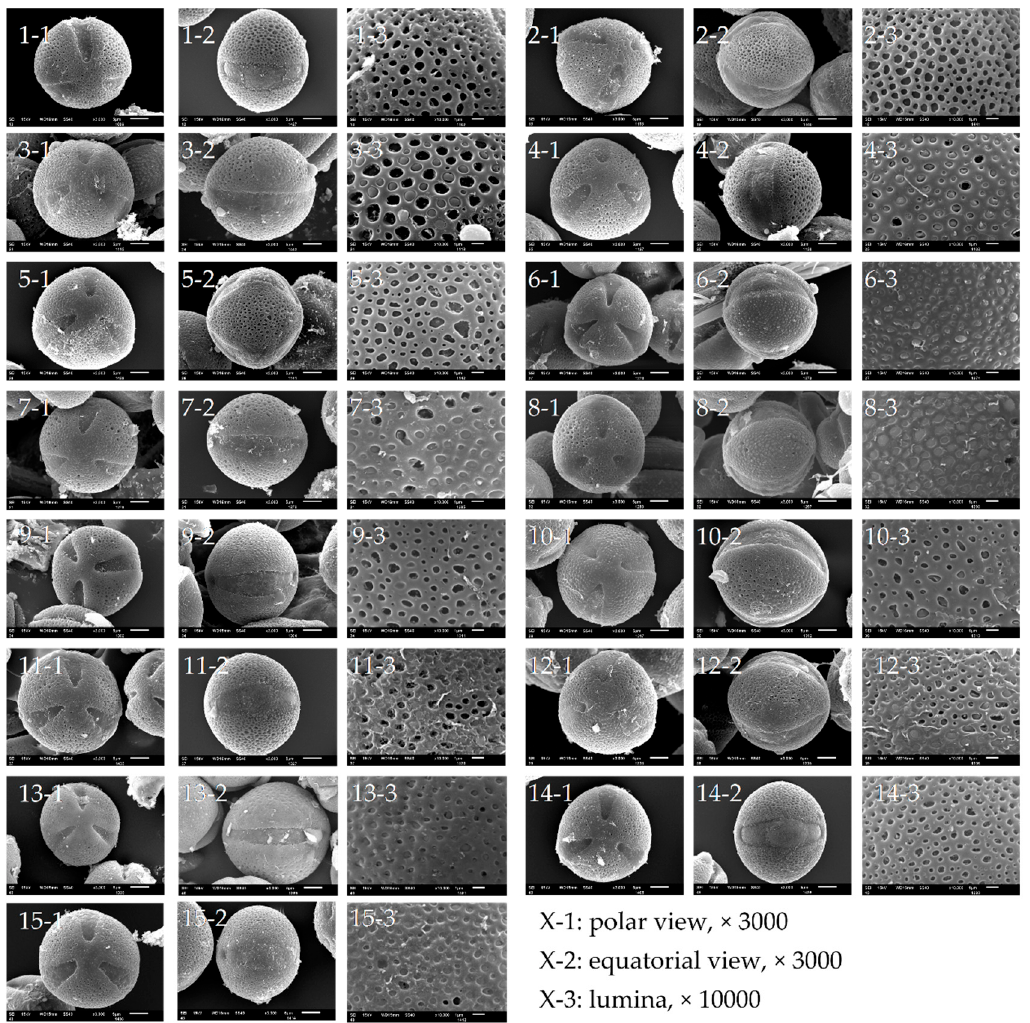
Figure 2. Pollen morphological characteristics of Paeonia lactiflora varieties: 1-1, 1-2, 1-3: